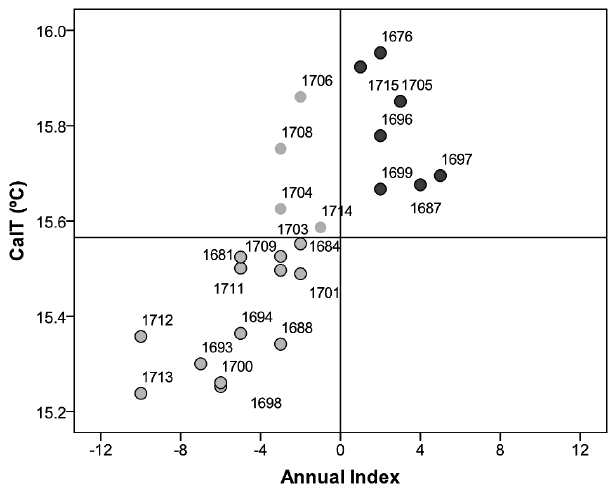
Figure 5. Scatter plot of CalT in the period of 1675–1715 as a function of the annual temperature indices. Light (dark) grey circles represent cold (hot) years from documentary evidence. Circles with black edges indicate agreement between the two data sets. Years with “0” index are omitted for the sake of readability of the plot. The horizontal line corresponds to CalT mean. Some labels are omitted for the sake of